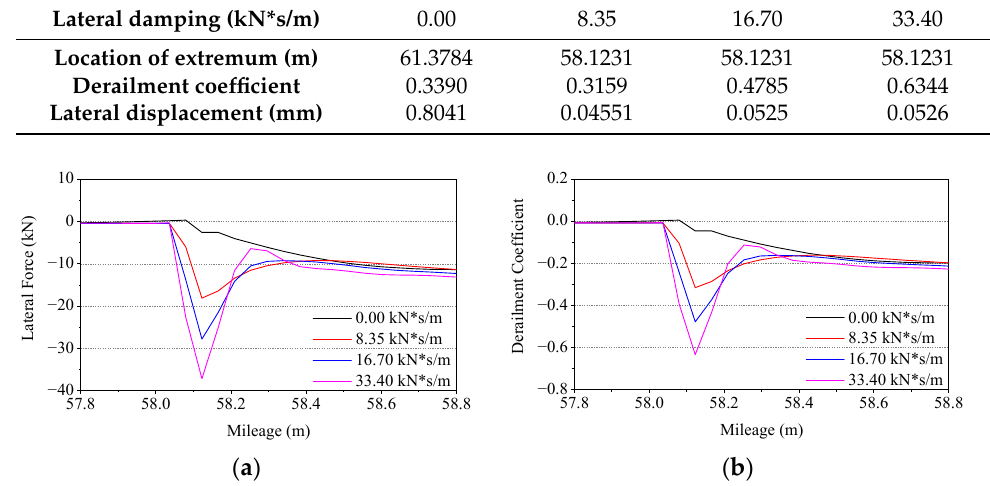
Figure 4. Wheel–rail lateral force and derailment coefficient under different lateral damping. ( a ) lateral force; ( b ) derailment coefficient.